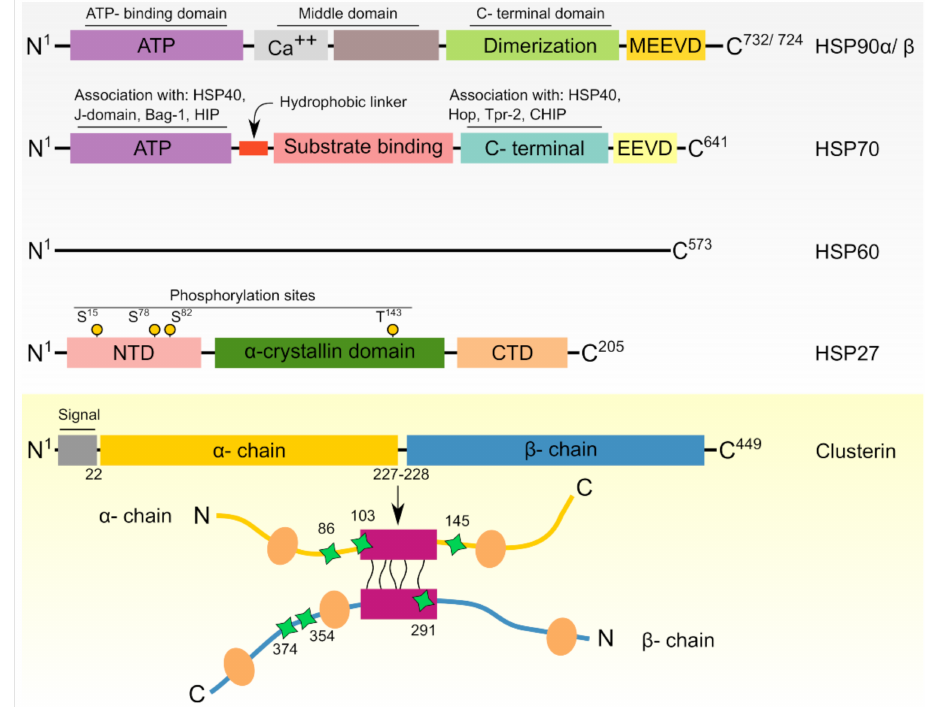
Figure 2. Domain architecture of common chaperones involved in PCa. From top to bottom, human HSPs including HSP90 α / β , HSP70, HSP60, HSP27, are displayed relative to their relative length